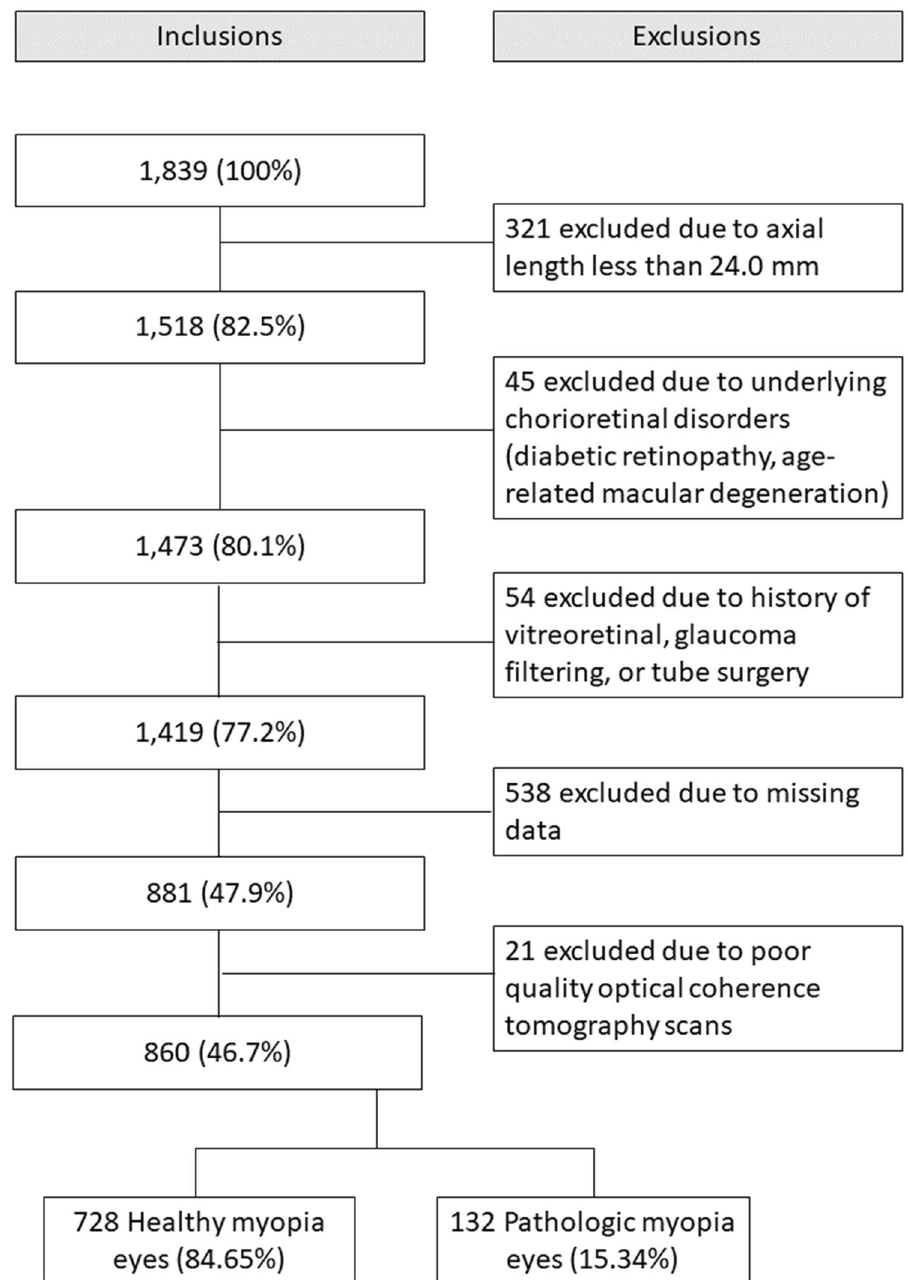
Figure 1. Inclusion, exclusion flowchart of the study